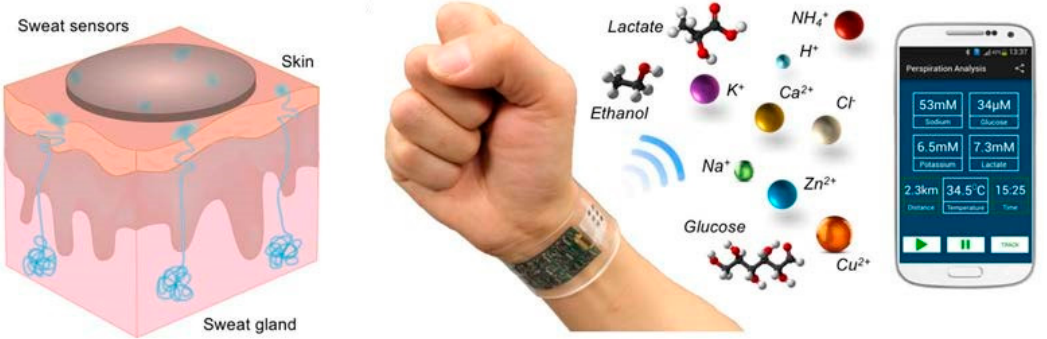
Figure 7. Wearable sweat biosensors which continuously measure a variety of sweat components for health monitoring. Reproduced from [164] with permission from IEEE.